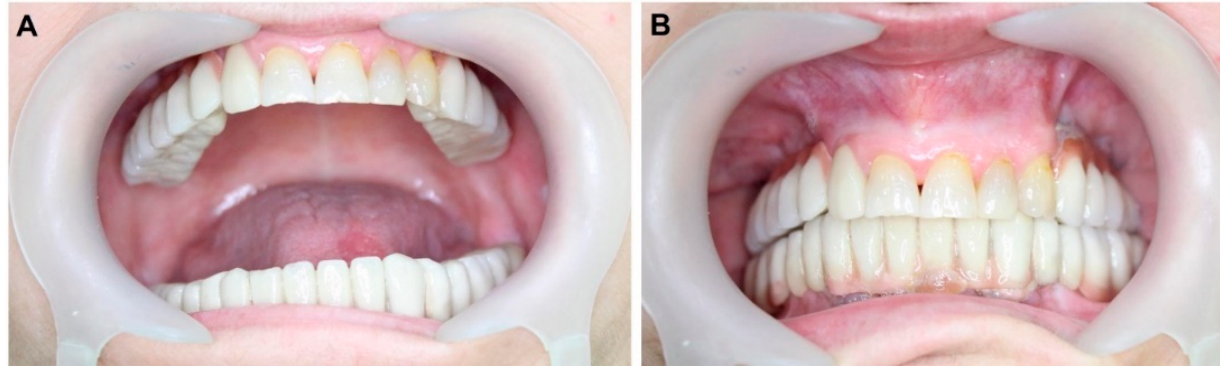
Figure 6. Final prosthesis, ten weeks post-surgery. ( A ) The view with the open mouth shows occlusion. ( B ) The closed mouth view shows the superstructure, vertical dimension and the smile line.